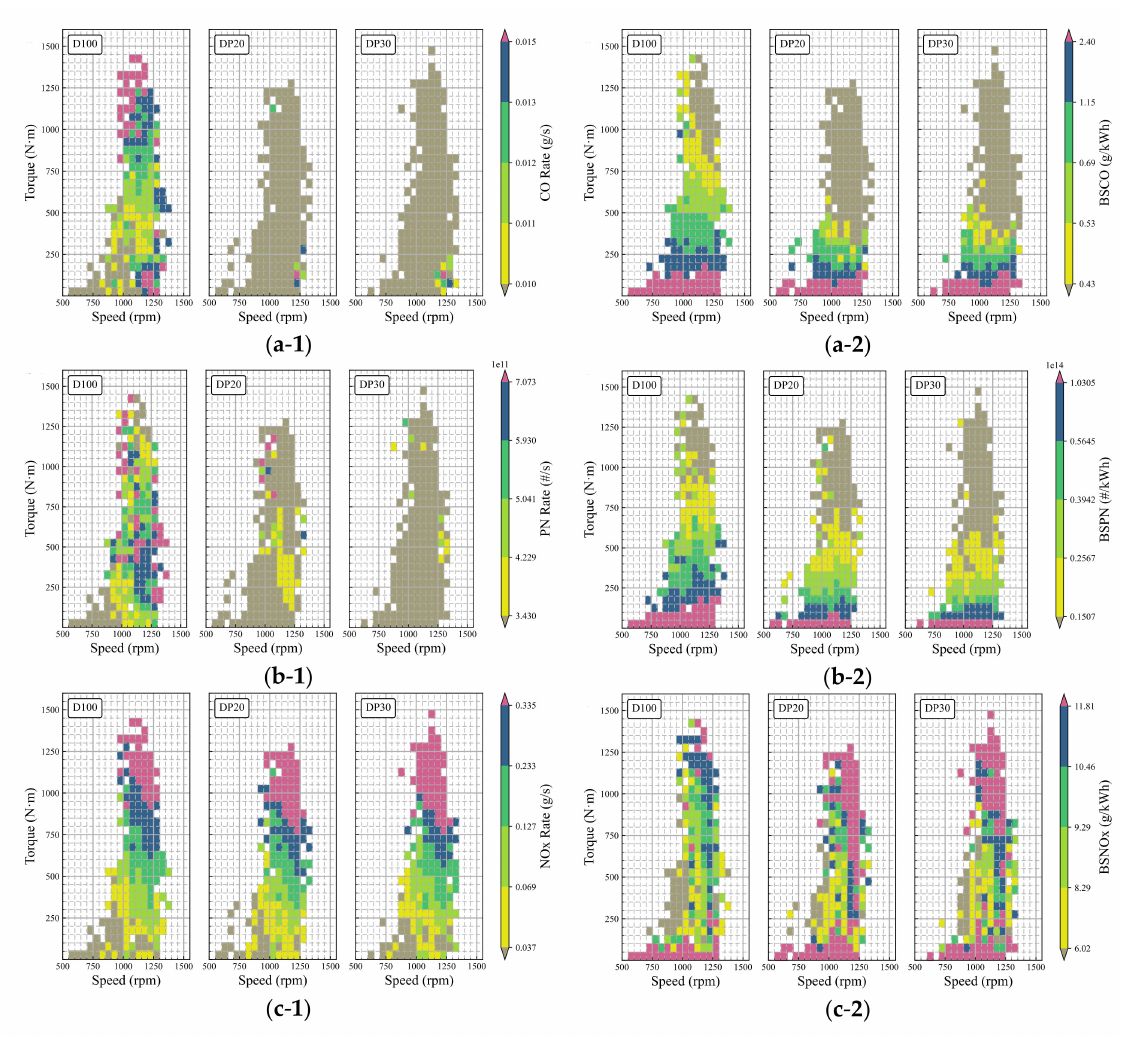
Figure 10. Transient engine maps of ( a - 1 ) CO, ( b - 1 ) PN, ( c - 1 ) NOx emission rates and brake specific ( a - 2 ) CO, ( b - 2 ) PN, ( c - 2 ) NOx emissions. The decreases in DSPN and BSPN are both positively correlated with the PODE blending ratio. DP20 and DP30 reduce DSPN and BSPN by approximately 40% and 55%,